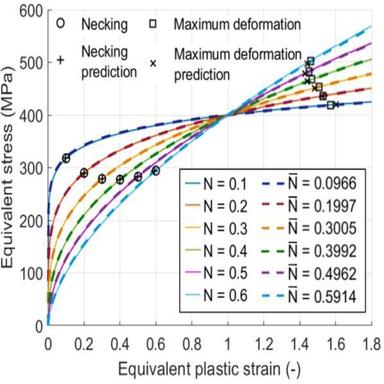
The table compares the expected value of N with the optimum one N identified by the proposed method; it also presents the error on the profile. In the plot dashed lines represent the plastic flow curve identified by the proposed method whereas continuous lines represent the plastic flow curve used to numerically generate the target profile; the actual necking onset and the actual maximum deformation are compared with the prediction done through the identified hardening law.